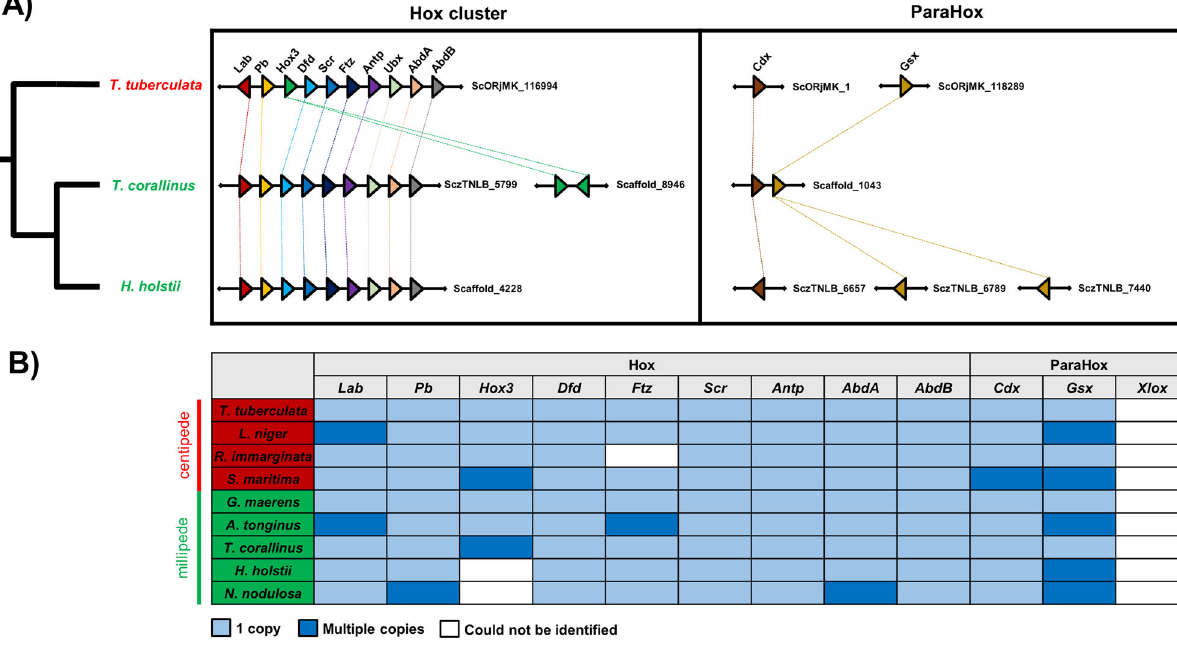
Fig. 4 Hox and ParaHox in sequenced myriapod genomes. A Microsynteny of Hox and ParaHox clusters in H. holstii , T. corallinus and T. tuberculata. B Hox and ParaHox genes annotation in sequenced myriapod genomes. The species labelled in green are millipede species while the species labelled in red are centipede